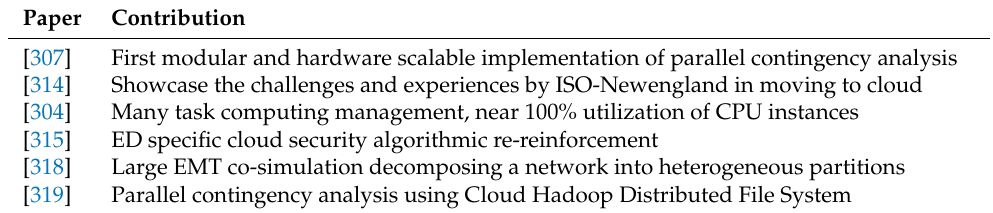
Table 11. Grid & Cloud Computing state-of-the-art studies.